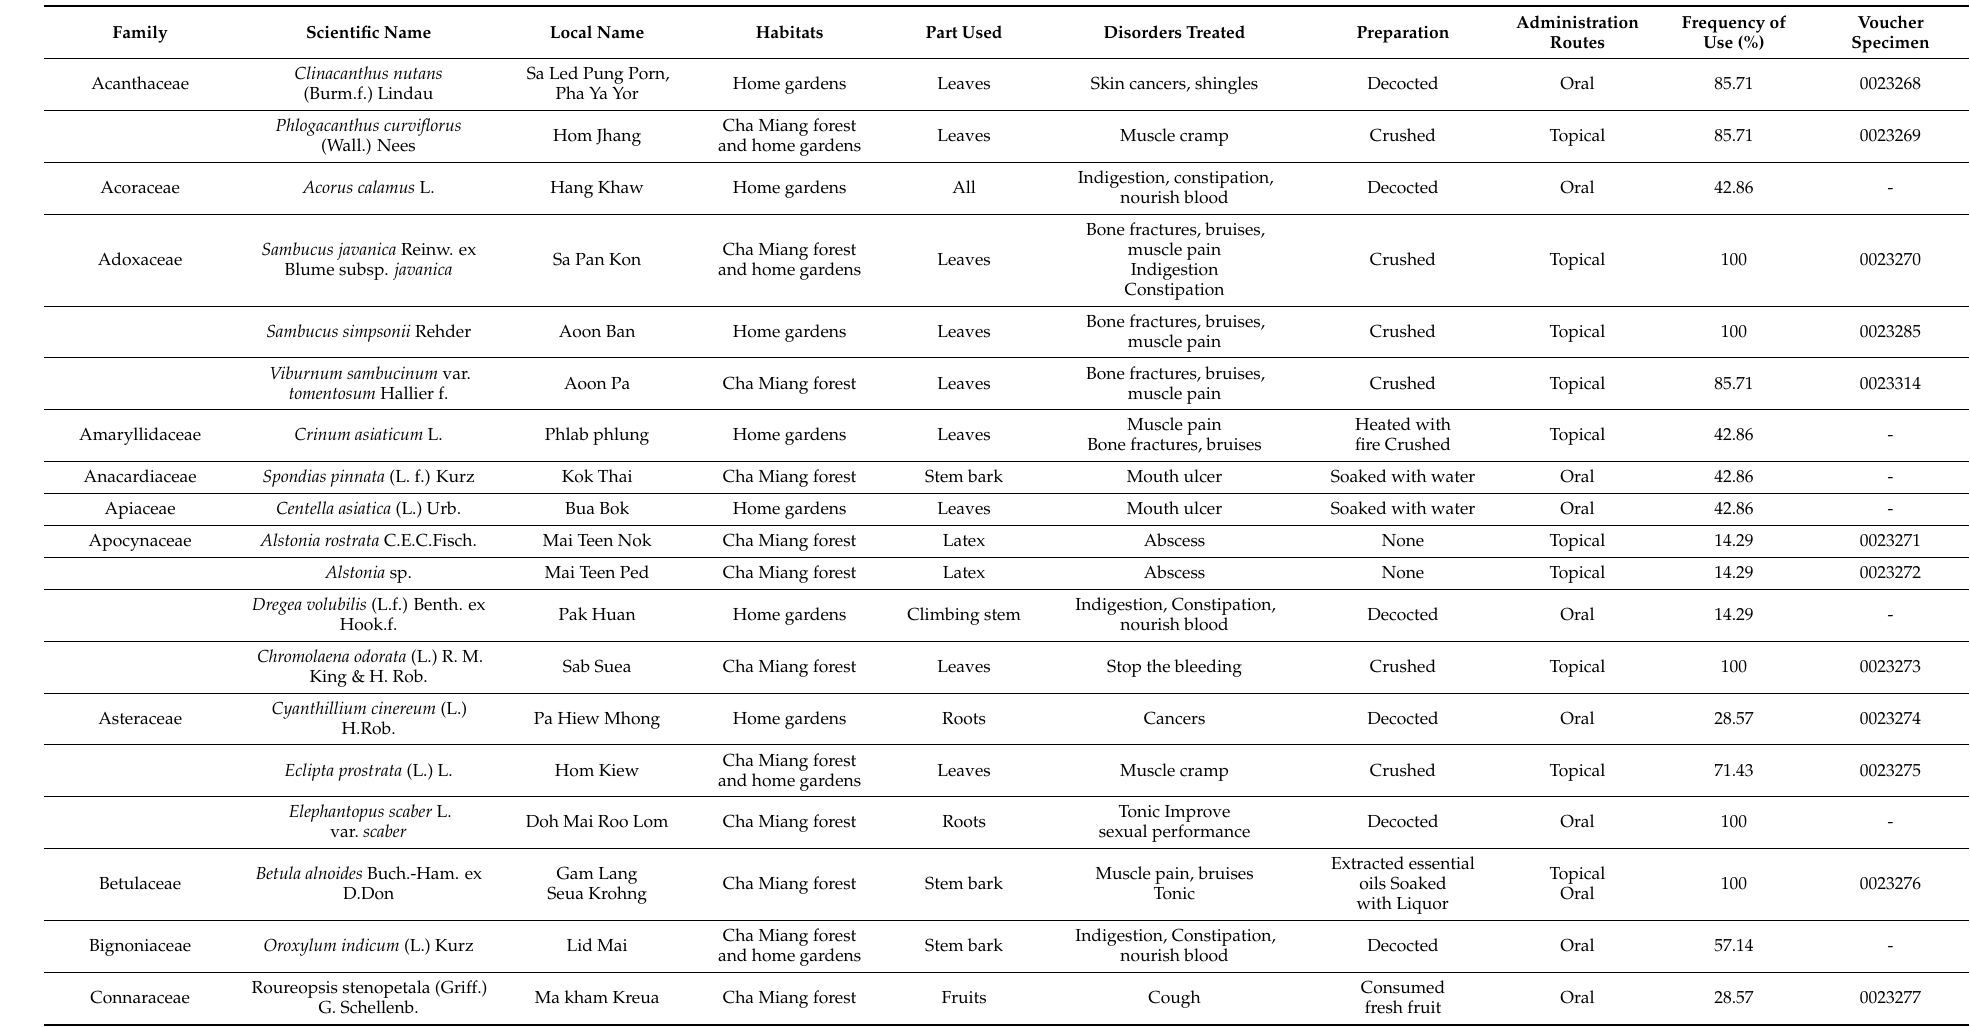
Table 2. Medicinal plant list of Mae Kampong Village, Huay Keaw Sub-District, Mae On District, Chiang Mai,